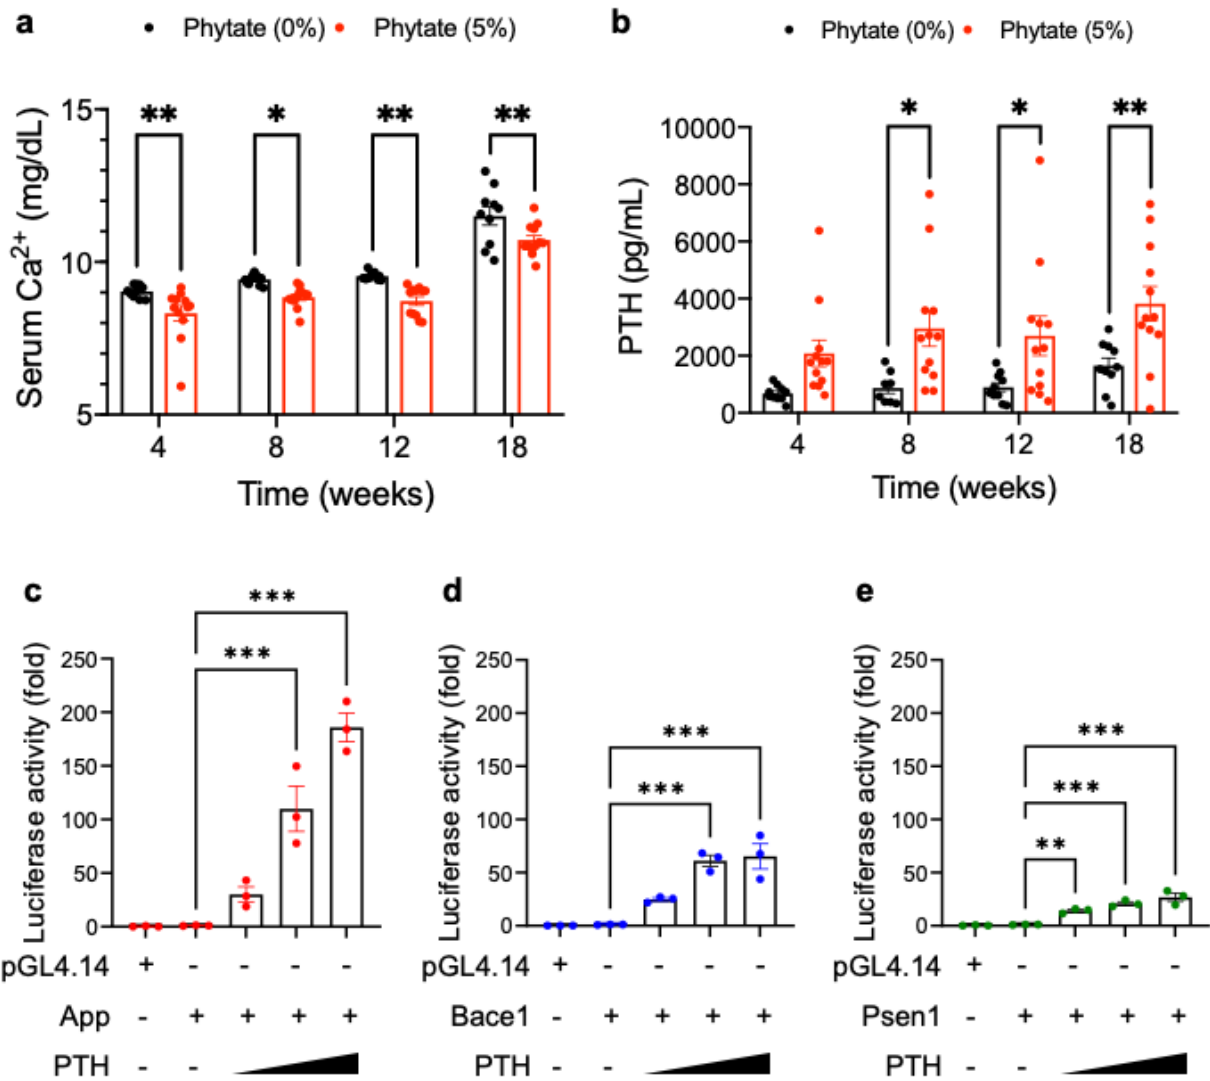
Figure 3. Rats fed high-phytate diets develop secondary hyperparathyroidism with hypocalcemia, and PTH affects the promoter activity of app and APP processing enzyme genes: ( a ) Serum levels of Ca 2+ of all groups during 18 weeks of feeding with the experimental diets. ( b ). Serum levels of intact PTH were measured with enzyme-linked immunosorbent assay (ELISA). Two-way ANOVA was used for all comparisons with Sidak’s multiple comparison test. All data are presented as mean ± SEM for each group ( n = 9–12). * p < 0.05, ** p < 0.01, *** p < 0.001 compared with controls. ( c – e ). The effects of PTH on the transcriptional activation of app ( c ), bace1 ( d ), or psen1 ( e ) mouse promoters. Standard luciferase-based transcriptional reporter assays were conducted in HEK293T cells transiently cotransfected with 0.1, 0.5, or 1.0 µg pcDNA-PTH; the luciferase vectors pGL4.14- app , pGL4.14- bace1 , or pGL4.14- psen1 ; and 0.1 µg of pRL-TK Renilla luciferase to normalize for transfection efficiency. Data show the mean ratios for multiple experiments (±SEM). One-way ANOVA was used for all comparisons with Dunnett’s multiple comparison test. All data are presented as mean ± SEM for each group ( n = 3–4 lpf/rat). * p < 0.05, ** p < 0.01, *** p < 0.001 compared with controls.